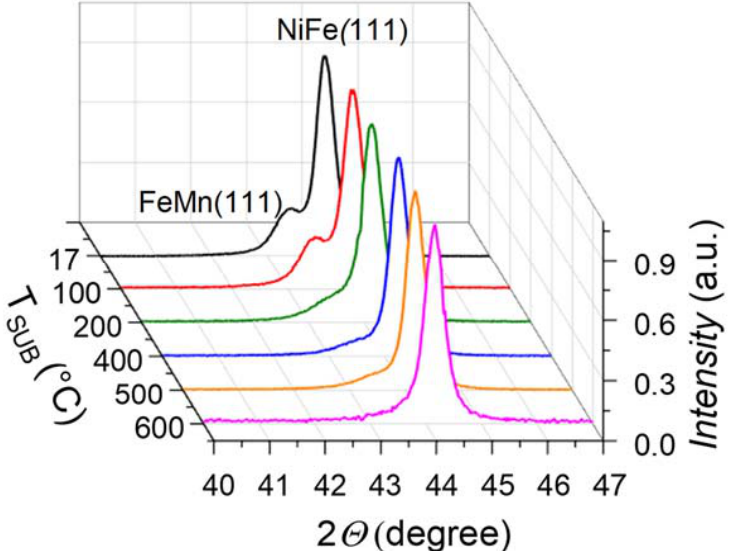
Figure 3. XRD patterns of NiFe (40 nm)/FeMn (20 nm) thin film structures deposited at different substrate temperatures ( T SUB ( ◦ C)).